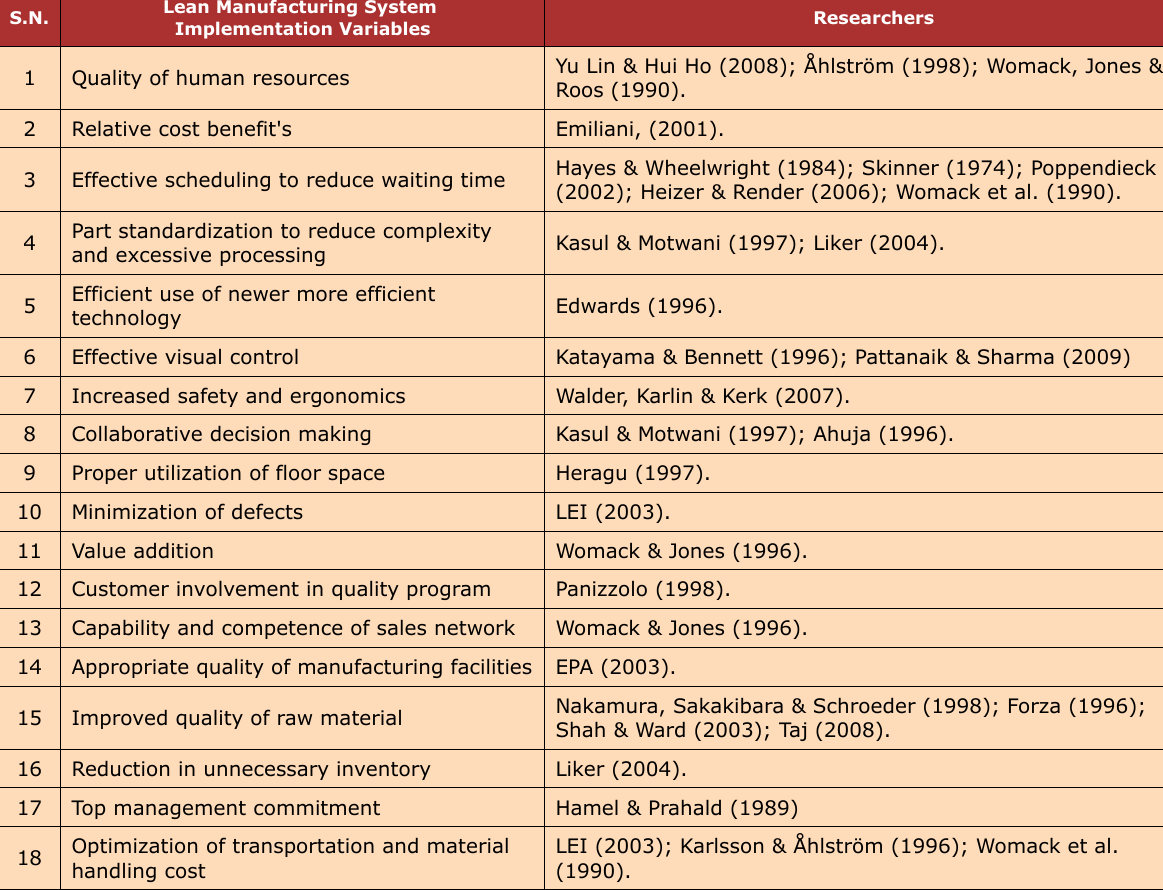
Table 1. Variables Used in ISM Modeling of Lean Manufacturing System